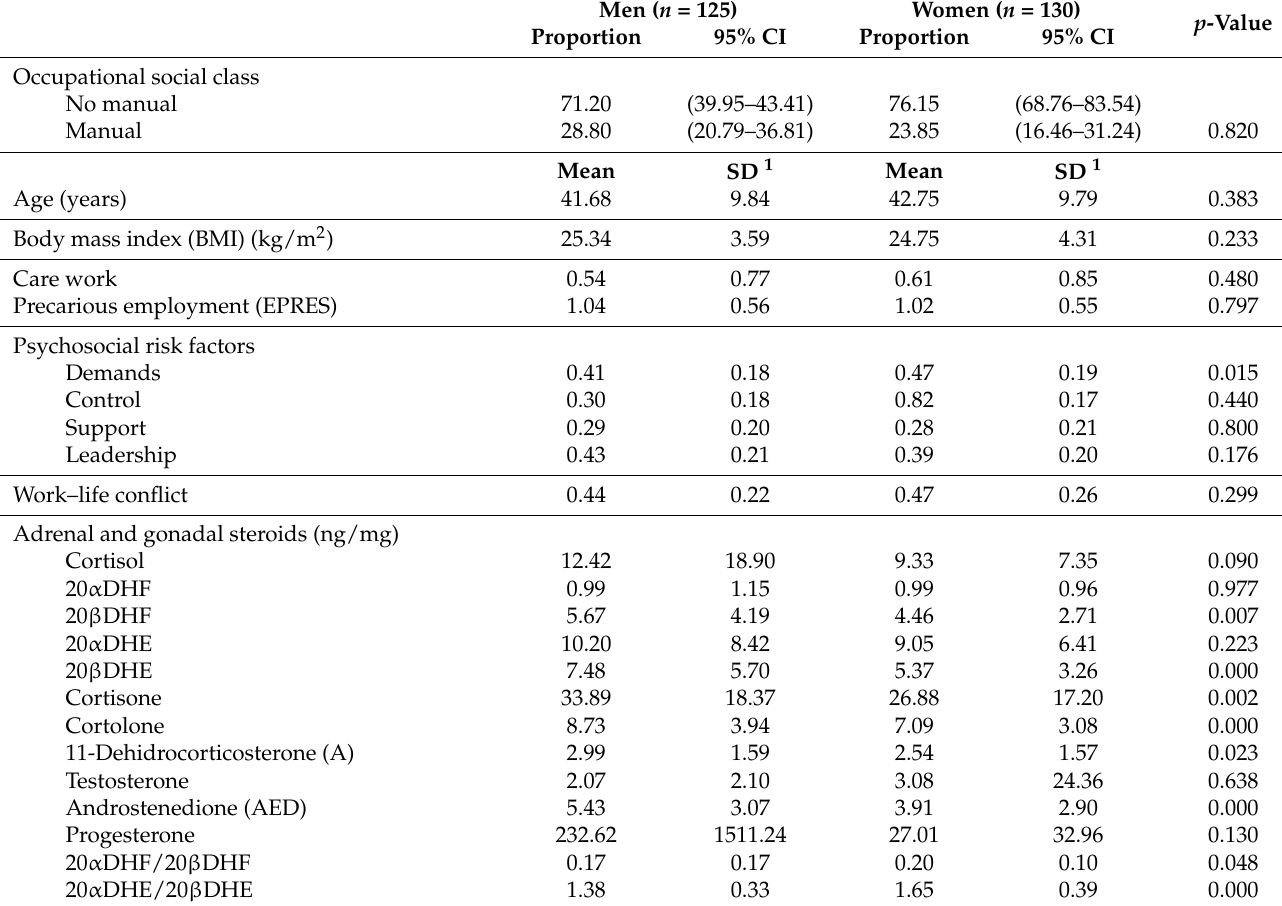
Table 1. Characteristics of the study population stratified by sex. Precarious Employment and Stress Study sample, 2020 (95% CI = 95% confidence interval, SD = standard